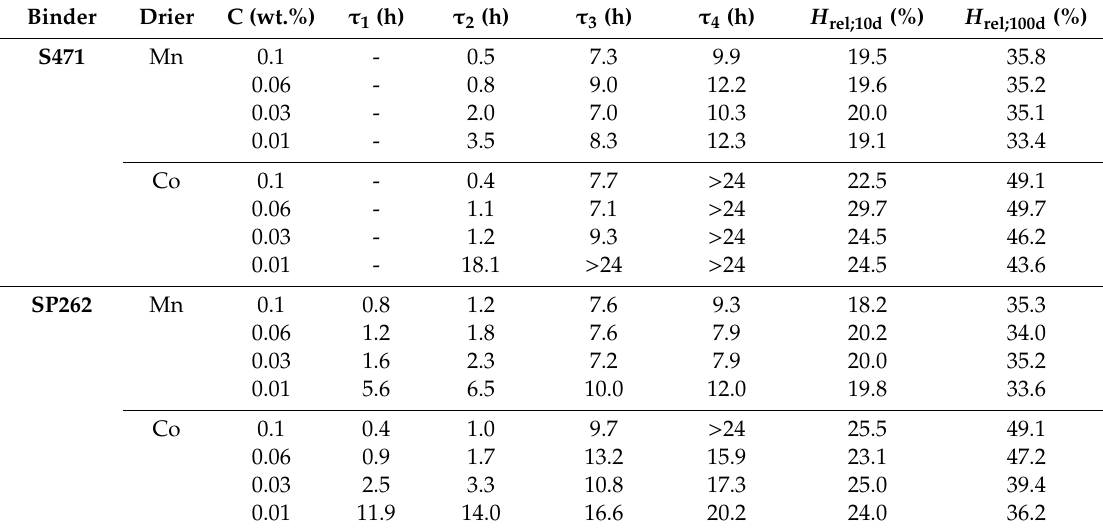
Table 1. Drying times and relative hardness for formulations of medium oil-length alkyd resins. Binder Drier C (wt.%) τ 1 (h) τ 2 (h) τ 3 (h) τ 4 (h) H rel;10d (%) H rel;100d (%) Mn